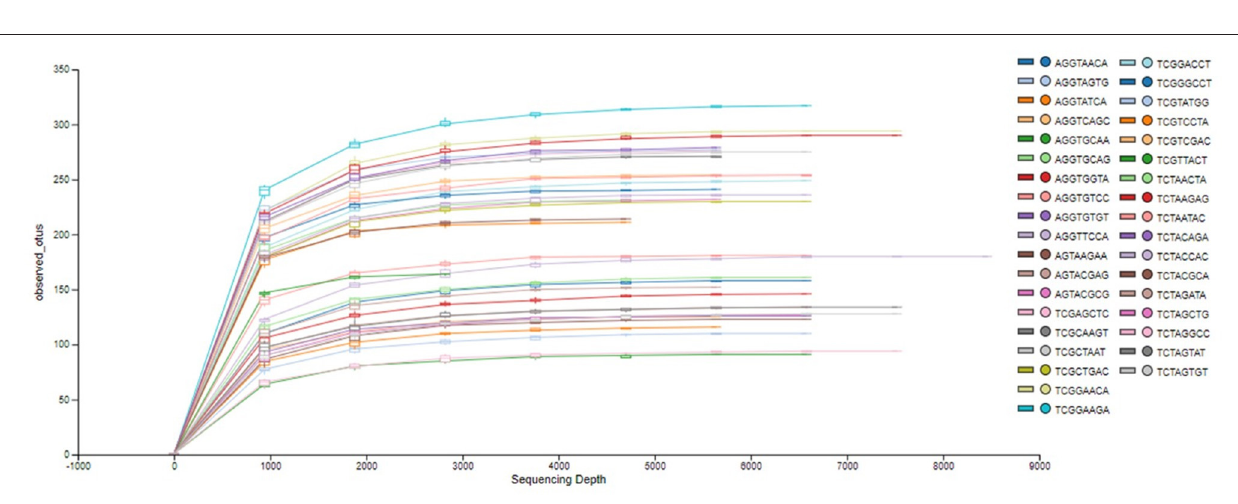
FIGURE 2 | Phylogenetic rarefaction curves estimating species richness. The rarefaction curves produce smoother lines facilitating full dataset comparison by reaching a clear